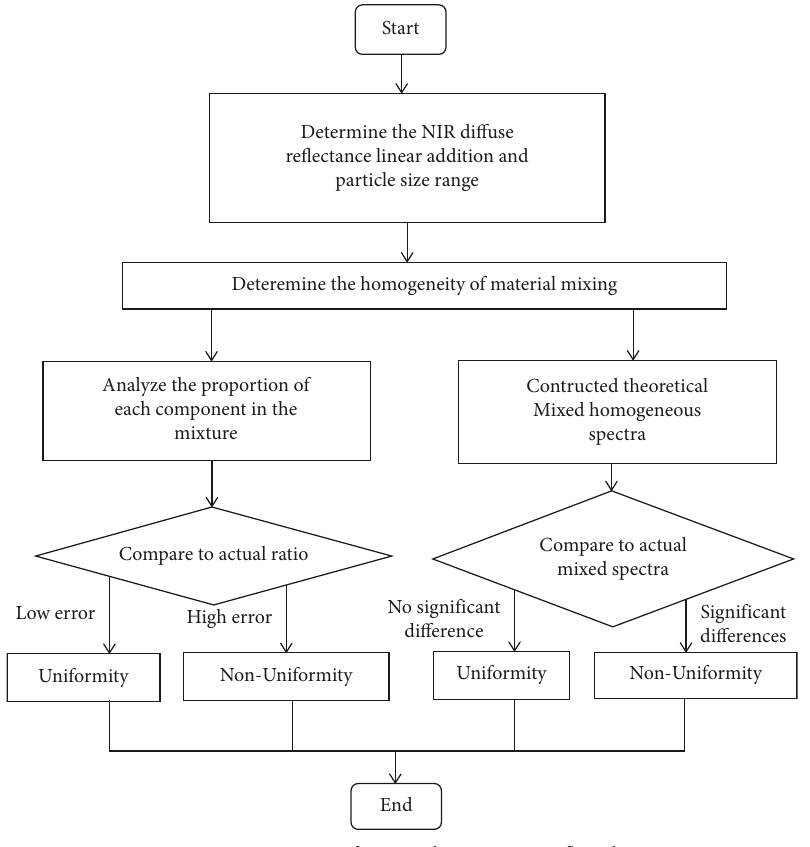
Figure 5: Mixing uniformity determination flowchart.